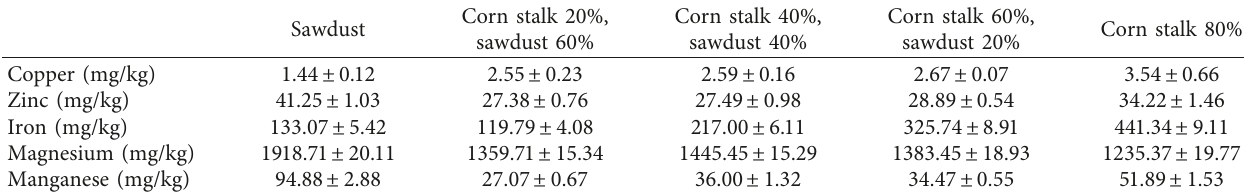
Table 2: Effect of different additions of corn stalks on the micronutrients of the Auricularia auricula .